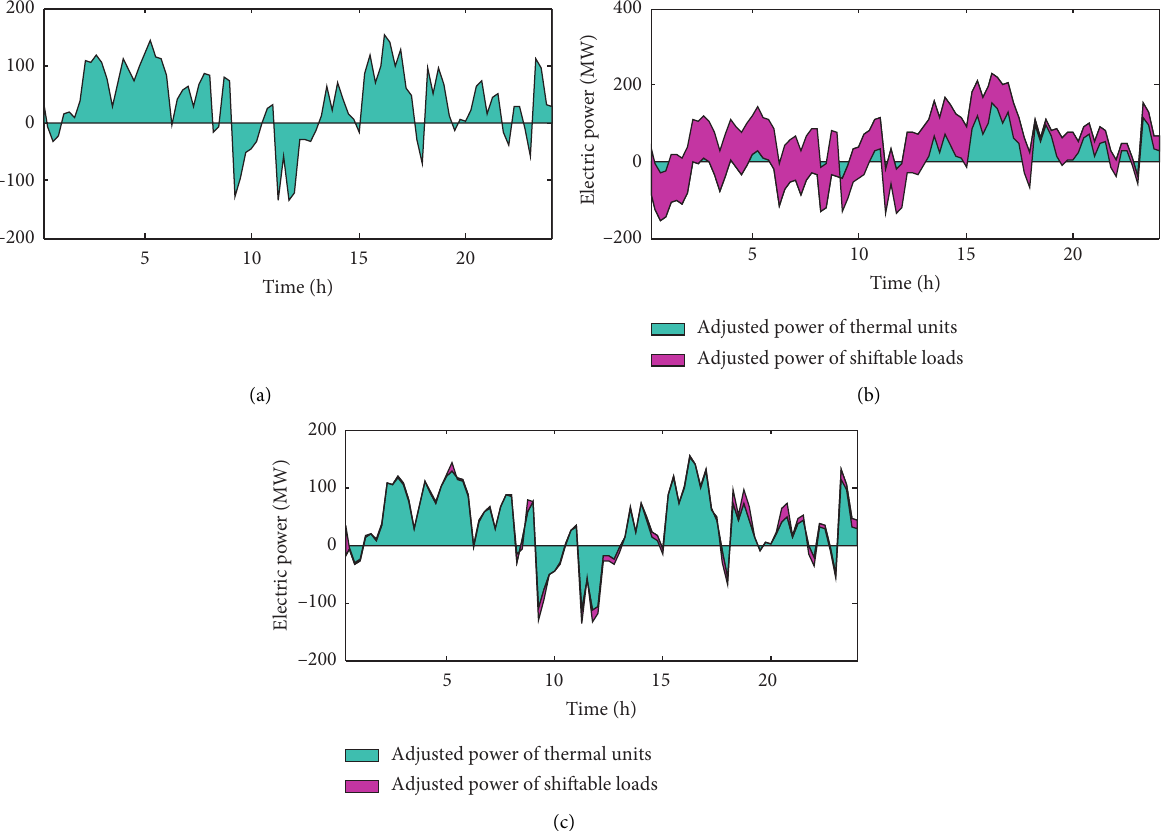
Figure 7: Adjusted power in the intraday scheduling. (a) Difference between day-ahead and intraday forecasting error. (b) Adjusted power of Method 2. (c) Adjusted power of Method 3 (the proposed